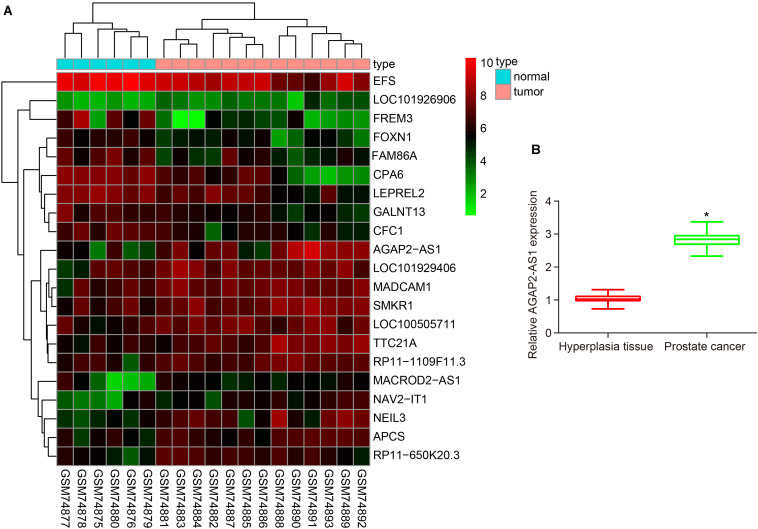
LncRNA AP2-AS1 is expressed at high levels in prostate cancer tissues. (A) LncRNA AGAP2-AS1 expression in the microarray GSE3325. (B) LncRNA AGAP2-AS1 expression examined by RT-qPCR in prostate cancer tissues (n = 50) and BPH tissues (n = 20). *p < 0.05 vs. the BPH tissues.